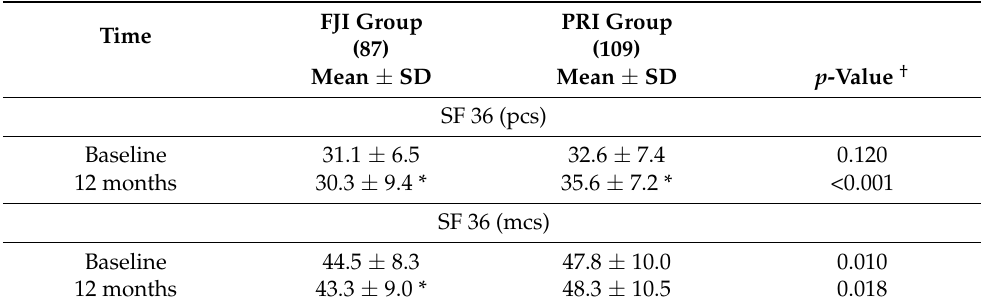
Table 4. Comparison of SF-36—physical and mental health summary scale (pcs + mcs) between the groups over time.